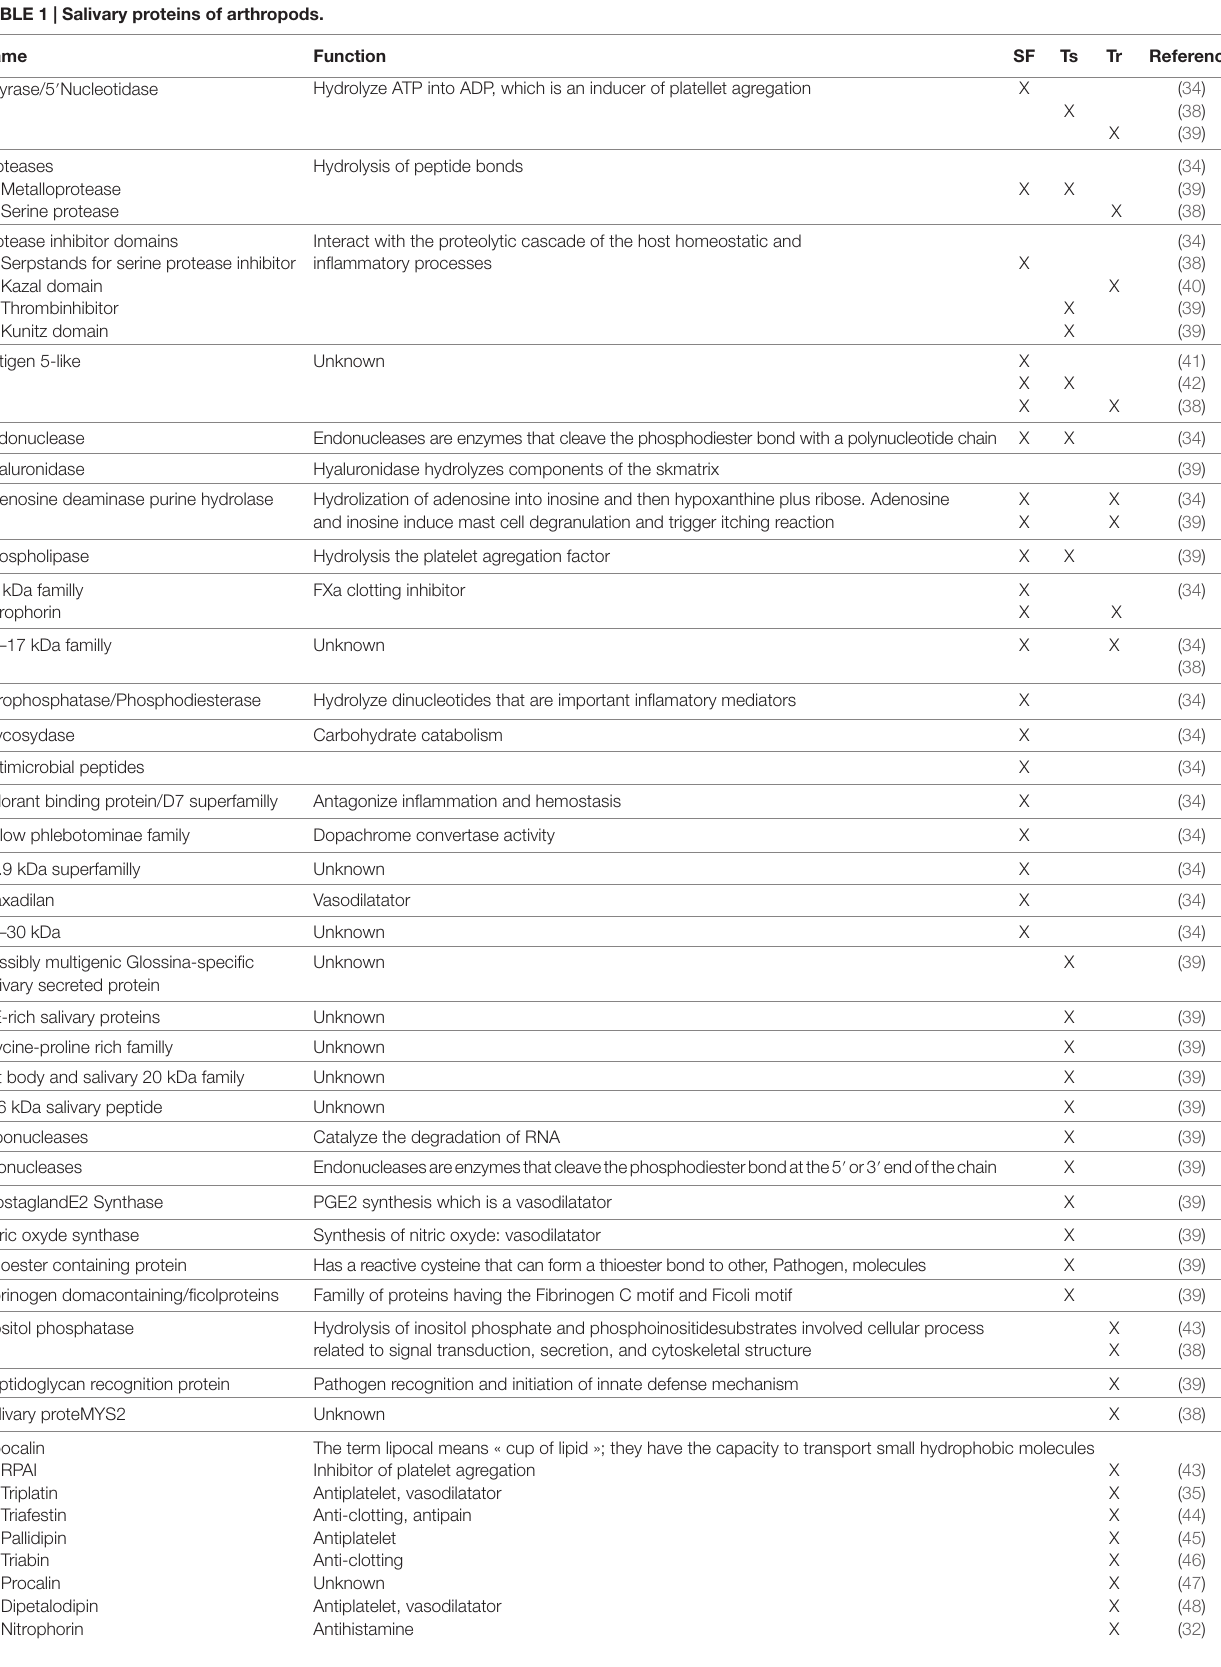
TABLe 1 | Salivary proteins of